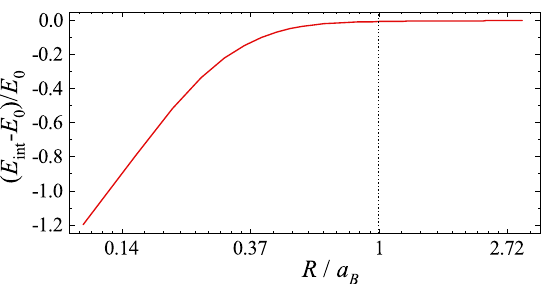
Figure 2. Correction to the binding energy of an exciton stemming from the finite value of the radius of the ring R calculated according to Equation (10). The correction plays essential role only in the region R < a B , while for higher values of the radius the binding energy quickly converges to E 0